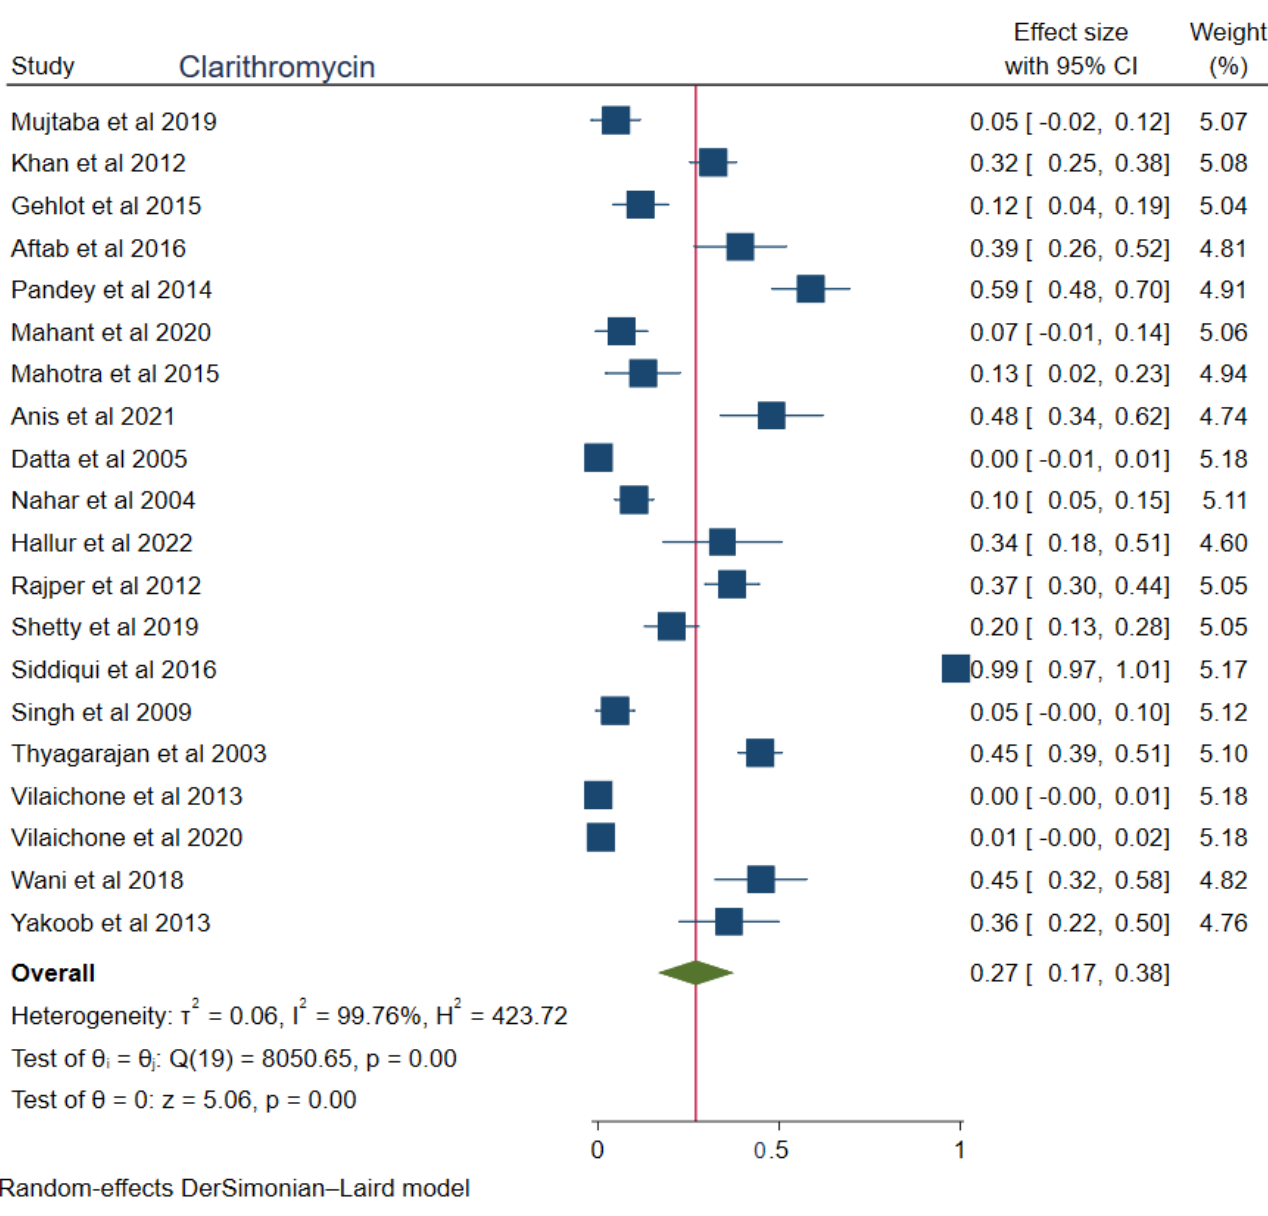
Figure 3. Forest Plot Showing Clarithromycin Resistance. (Reference Studies: [15, 20-25, 27-32, 34-40])